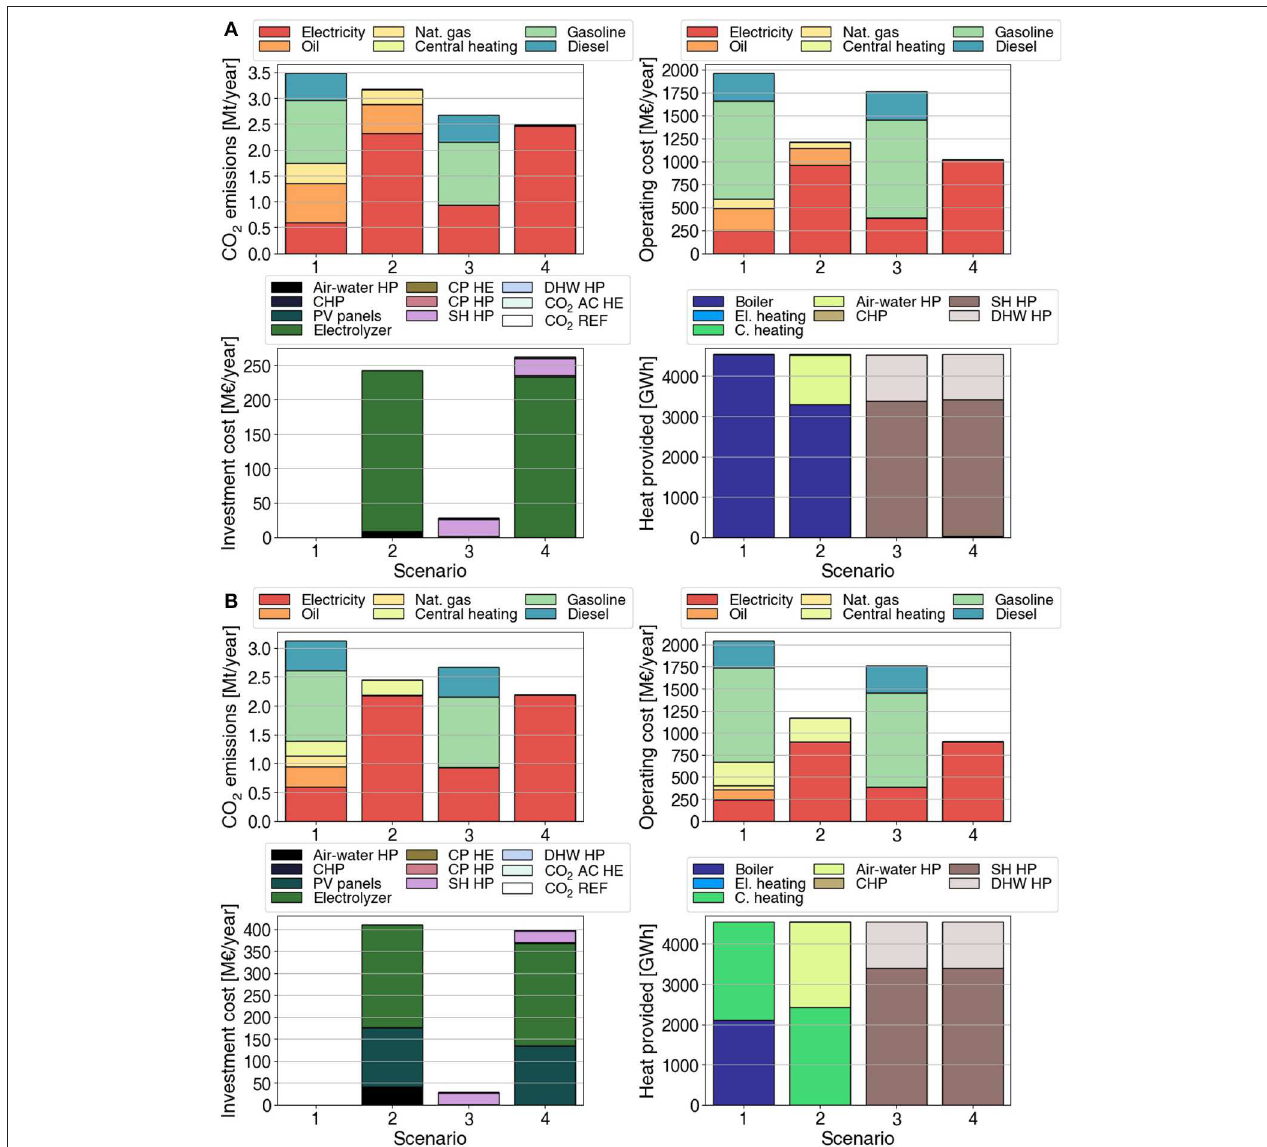
FIGURE 10 | Total cost optimization for different scenarios (A) , Environmental impact optimization for different scenarios (B)